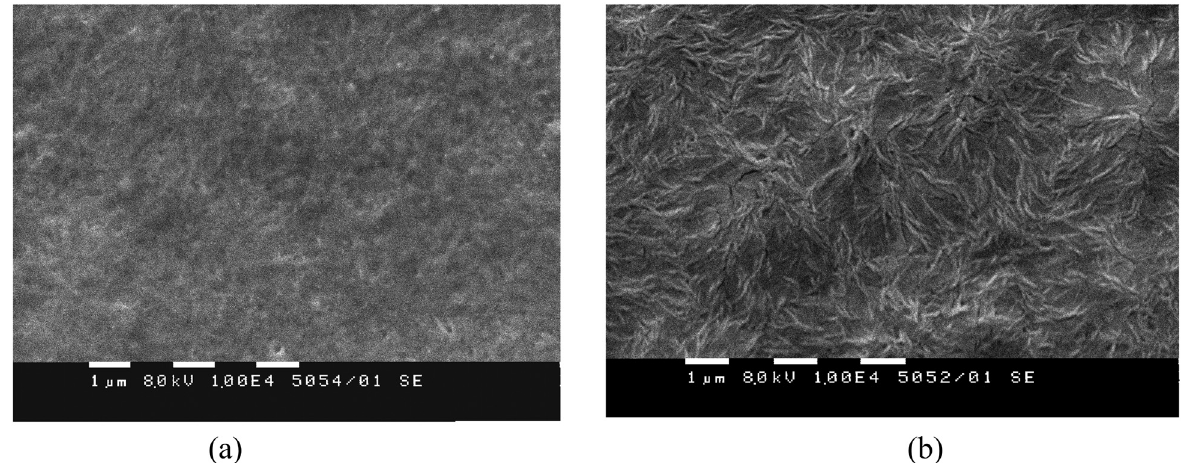
Figure 2: SEM images of PEDOT:PSS coating: ( a ) non - textured and ( b ) textured during its growth on the SAW excited